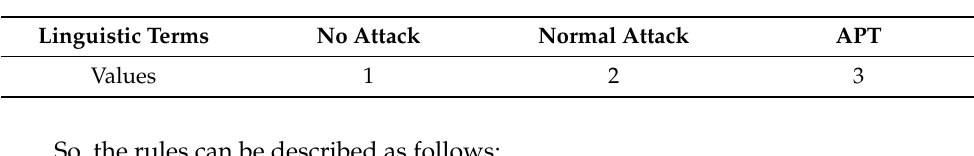
Table 7. Reference values of the